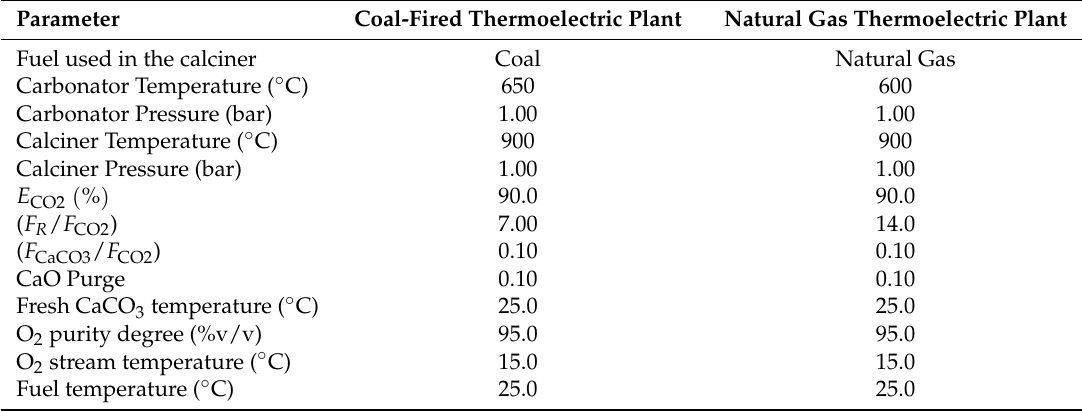
Table 4. Process parameters that specify the Calcium Looping system for each type of thermoelectric plant. Parameter Coal-Fired Thermoelectric Plant Natural Gas Thermoelectric Plant Fuel used in the